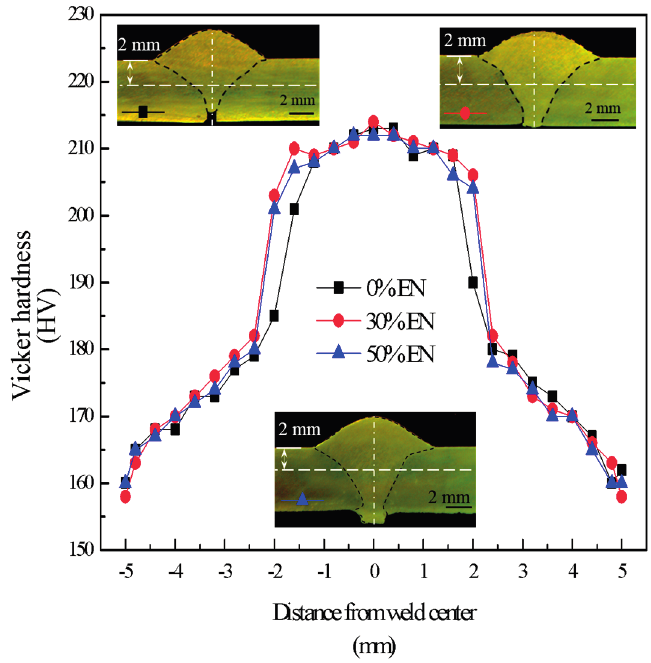
Figure 17. Vickers hardness distribution across weld